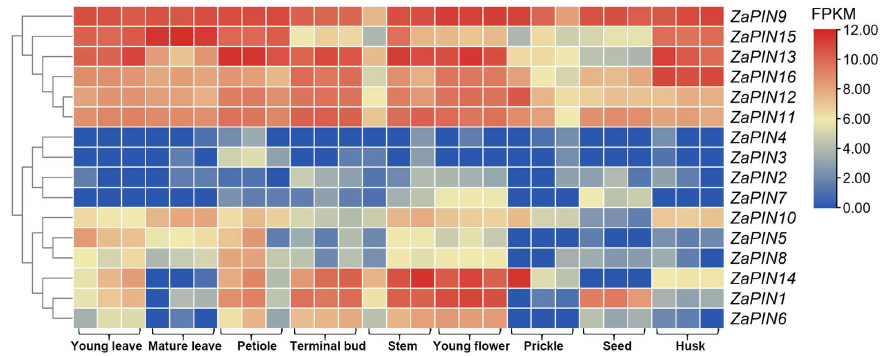
Figure 8. Expression profiles of ZaPINs in different tissues . Color scale represents logarithmic FPKM value (log2 FPKM): red represents high transcript levels and blue represents no transcripts or low transcript levels.